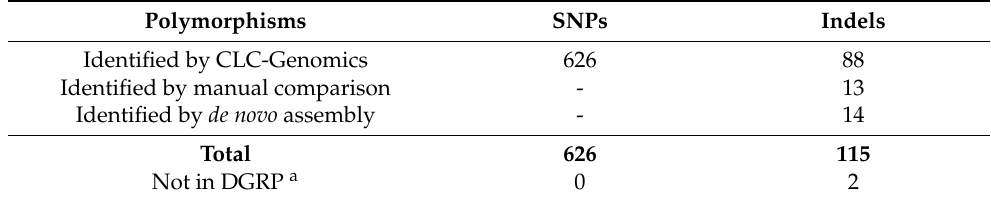
Table 2. SNPs and indels found in the Tel1 genome relative to the standard reference sequence of chromosome arm 3R between coordinates 19,325,278 and 19,404,278.